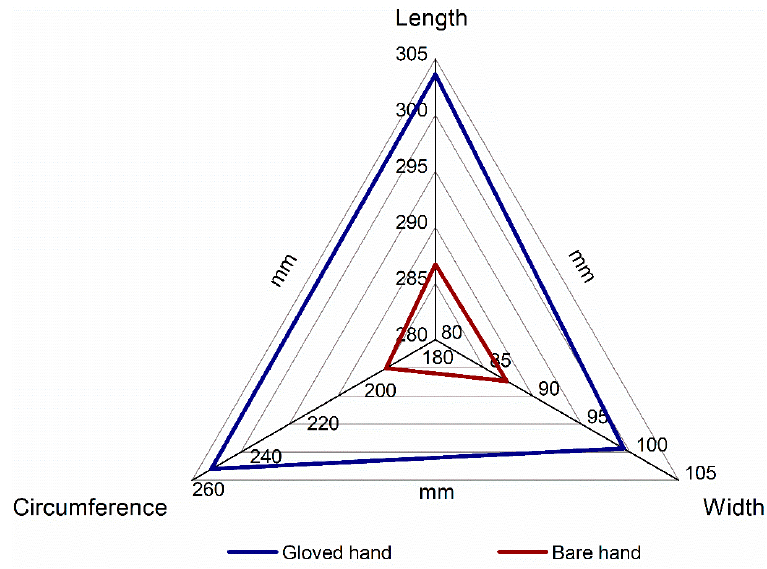
Figure 5. Spider chart of the key anthropometric parameters obtained from 3D scan analysis for the bare and gloved hand.